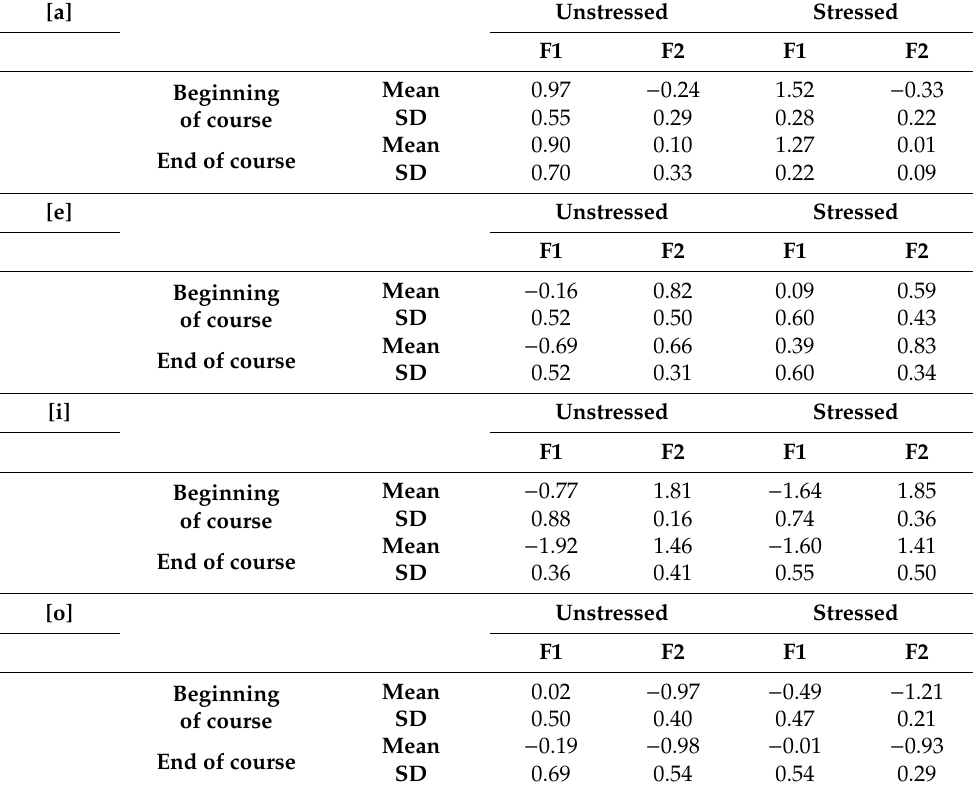
Table 5. Mean Lobanov-normalized F1 and F2 values for Informant